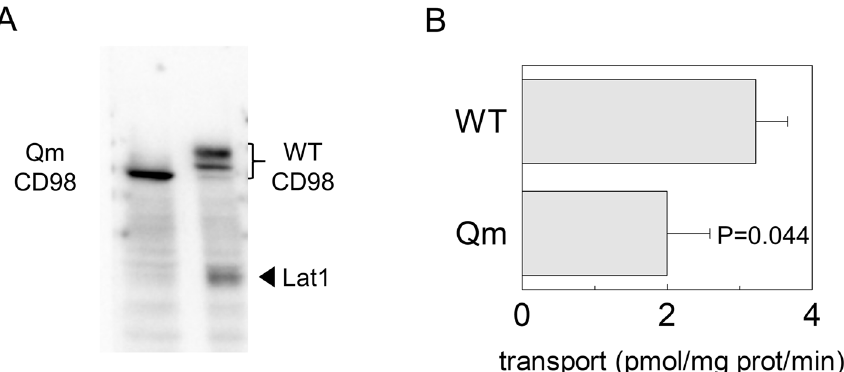
Figure 7. Cell surface biotinylation of CD98 and LAT1. In ( A ), Surface protein fractions isolated from HEK293 transfected with WT-CD98 (lane1) or Qm-CD98 (lane 2) constructs as described in material and methods. The obtained samples were tested for the presence of native LAT1 using an anti-LAT1 antibody 18 . WT and Qm mutant were also tested to ensure that sufficient amount of membrane protein fraction was loaded in the gel using anti-FLAG antibody 33 . The western blot image is representative of three independent experiments. In ( B ), Uptake of [ 3 H]-histidine in HEK293 cells. HEK293 cells were seeded and transfected with WT-CD98 or Qm-CD98 constructs as described in materials and methods; transport was started by adding 5 μM [ 3